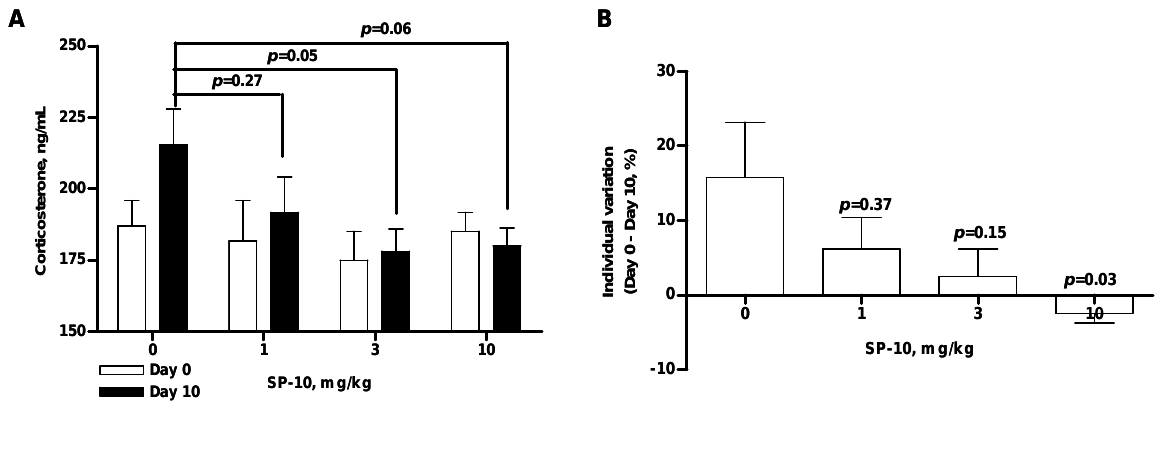
Figure 3. Male Long-Evans rats weighing 300-350 g were treated with the indicated concentrations of SP-10 once daily (i.p.) for 10 consecutive days. Blood (400  L) was collected prior to dosing (Day 0) and 24 hours after the final dose (Day 10). Serum corticosterone levels were measured by radioimunoassay. (A) Dose response effect of SP- 10 on Day 0 and Day 10 corticosterone concentrations. (B) Data in (A) are presented as the mean percent change in corticosterone levels from Day 0 to Day 10 to better illustrate the dose-dependent effects of SP-10. (ANOVA followed by Scheffe F test, n = 5 per